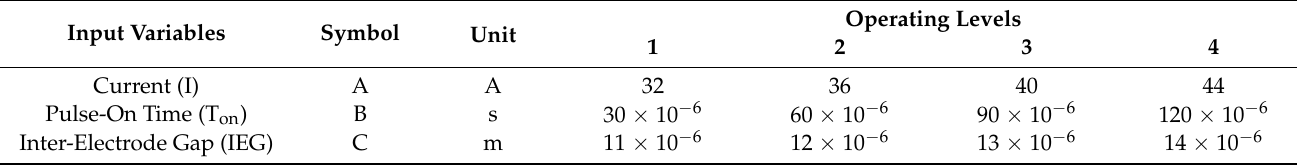
Table 3. Input factors and its operating